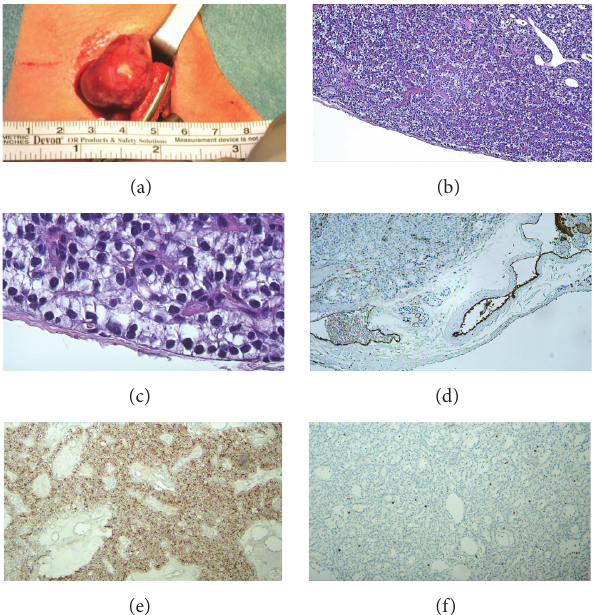
Figure 6: Parathyroid adenoma. (a) The patient underwent min- imally invasive video-assisted parathyroidectomy (MIVAP) with intraoperative PTH determinations (baseline and 20 minutes after tumor removal) and continuous intraoperative nerve monitoring. A left inferior parathyroid adenoma was successfully removed. The baseline PTH measurement was 678 pg, and 20 minutes after excision the PTH serum level was 47 pg. Postoperative progress was uneventful. The patient was discharged the day after the operation with the appropriate prescriptions. (b and c) Parathyroid adenoma with clear cells at a low and high grade of amplification; a thin fibrous capsule is present. (d) CD34 endothelial staining showed no evidence of angioinvasion. (e) PTH staining confirmed the functional activity of the tumor. (f) Ki-67 expression was low, confirming the benign nature of the tumor.